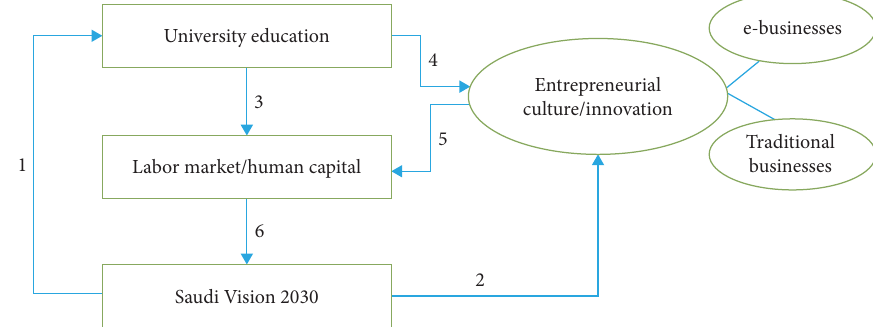
F IGURE 2: Saudi Vision Linkages Model. Source: by